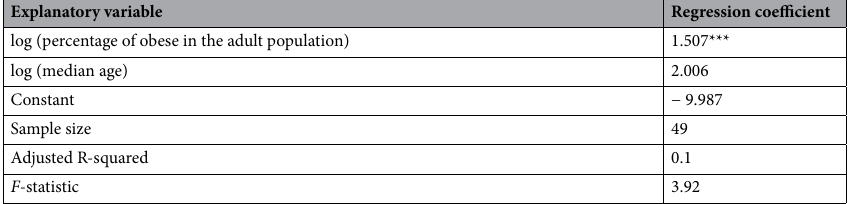
Table 2. COVID-19 Mortality and Proportion of Obese in Adult Population: High-Income Countries. Dependent variable is log of COVID-19 Mortality. ***indicates that a regression coefficient is statistically significant at 1% level.